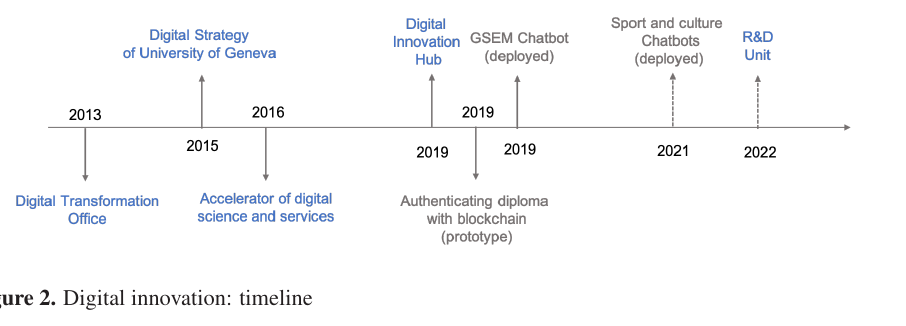
decision tree along with the stakeholders, and progressively add maturity to the agent. End user’s test complement the